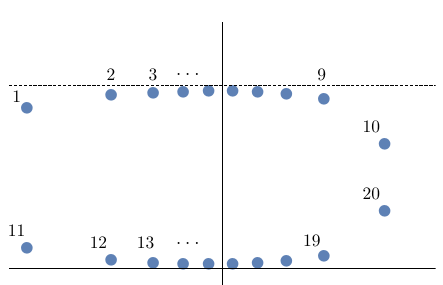
Figure 10. The Bethe roots for the state (cid:13)owing to a conformal descendent of dimensions ( (cid:22)(cid:1) ; (cid:1)+ 1). In this case the non-zero variations of the Bethe numbers from the reference distribution (32) are given by (cid:14)I M = 1 (recall that M is assumed to be even). Note that the set of Bethe roots obtained 2 through the CPT -transformation of the depicted set has (cid:14)I M = 1. The value of the parameters used for the plot are (cid:13) = (cid:25) , S z = 0, k = 1 and L = 20. 5 20